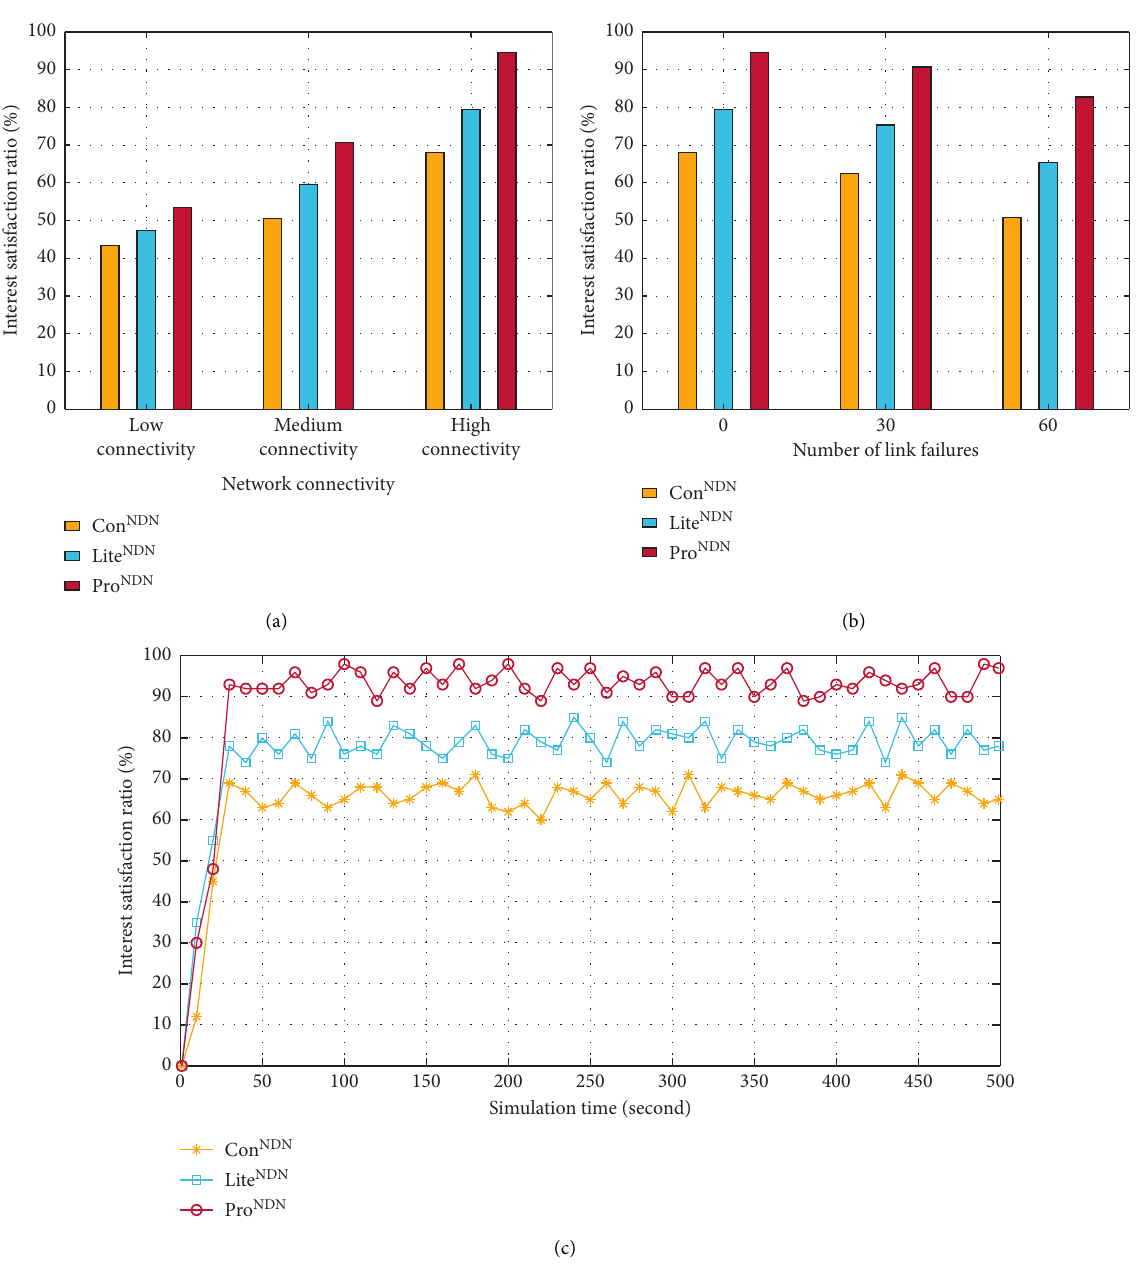
Figure 6: The performance of Interest satisfaction ratio against network connectivity, number of link failures, and simulation